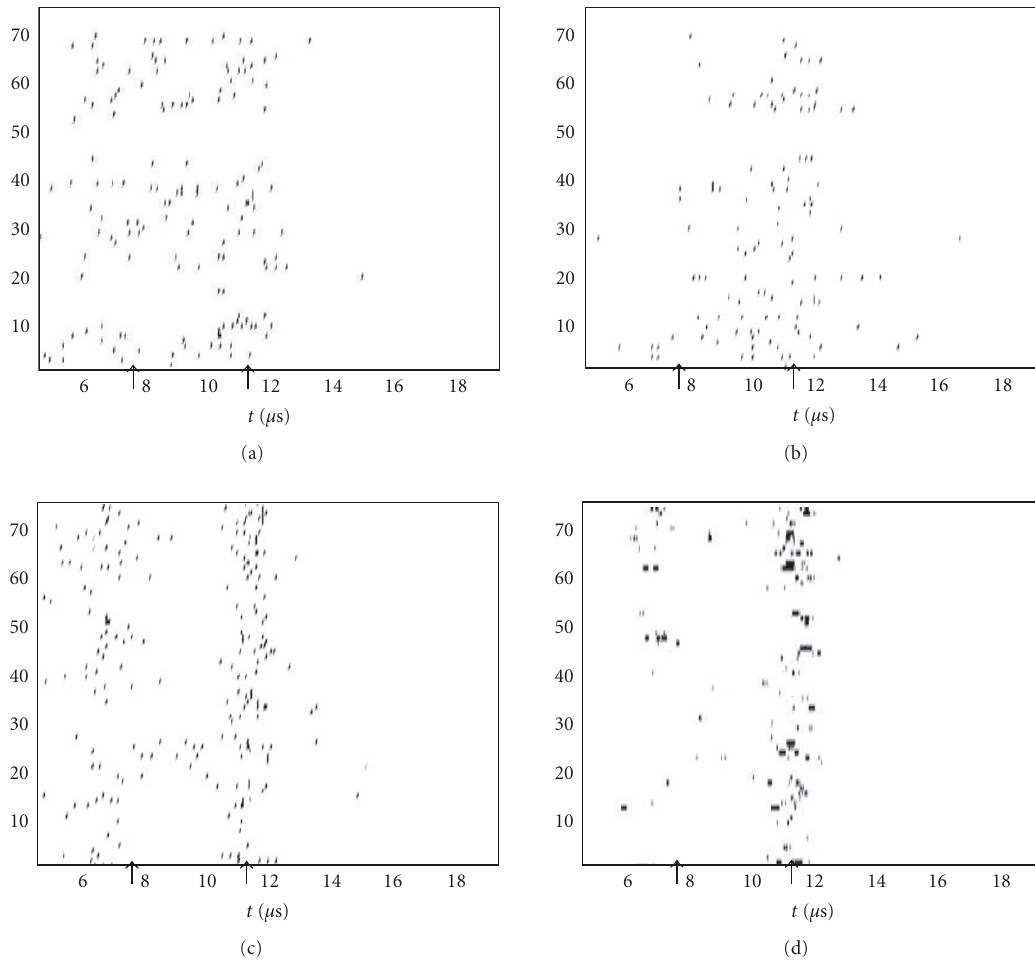
Figure 6: Detection results: (a) matched filter (Model 1), (b) gating of the original signal (Model 2), (c) gating of the prewhitened signal (Model 3), (d) suboptimum